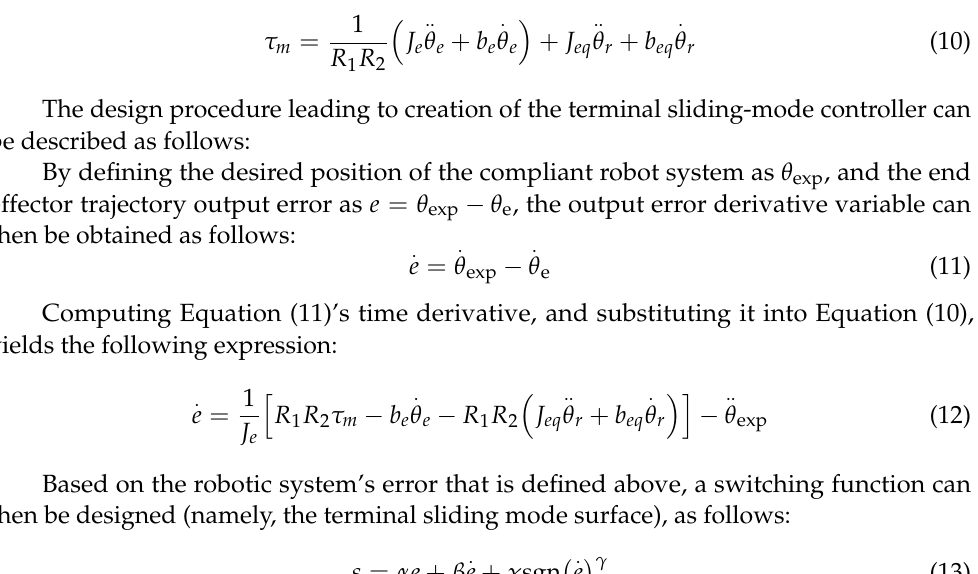
Figure 3. The schematic of TSM controller.